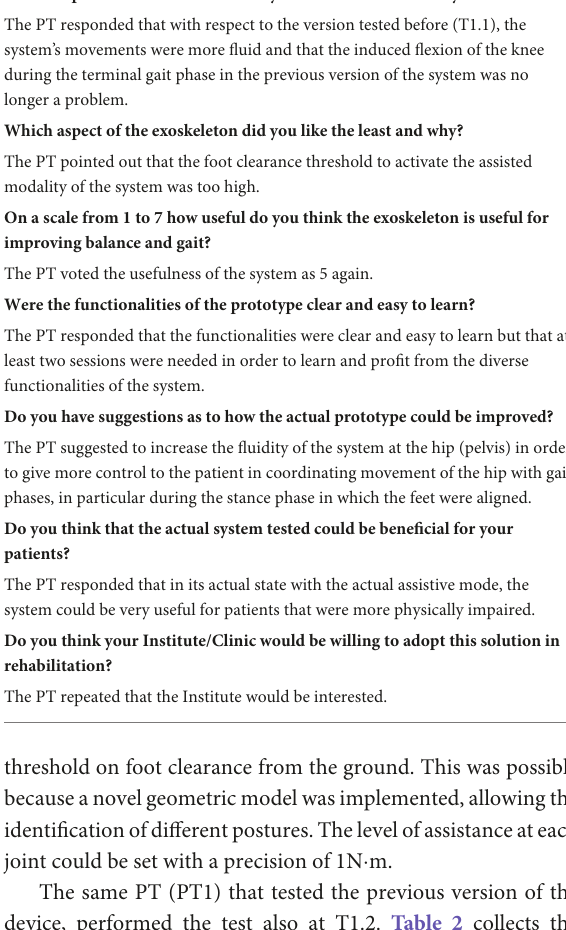
TABLE 1 Semi-structured questionnaire responses (items 4–10) provided at T1.1 by two PTs (PT1 and PT2).